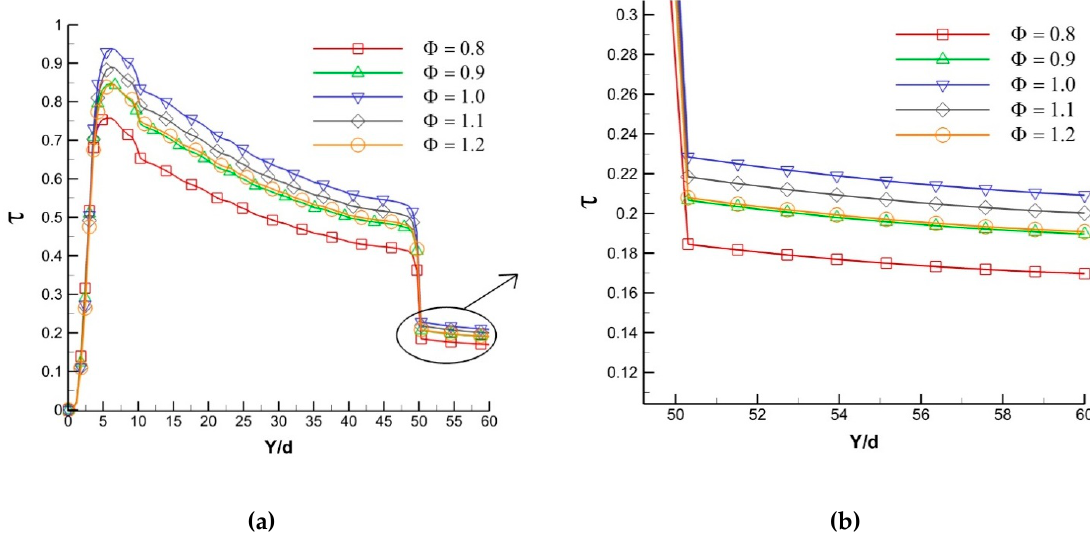
Figure 13. Temperature distribution for various equivalence ratios as a function of Y/d: ( a ) From the gas torch outlet to the steel plate; ( b ) enlarged part for only the steel plate thickness.